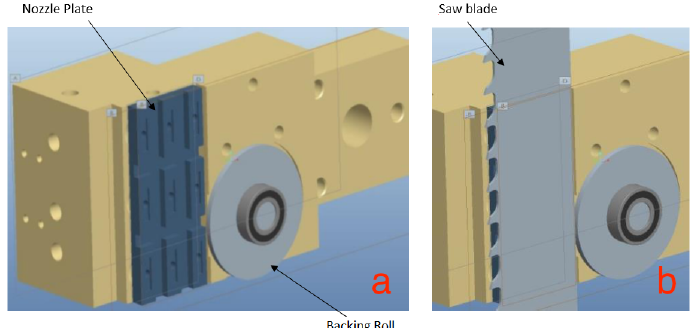
Figure 5. CAD design of the hydrostatic blade guide system showing the nozzle plate, backing roll, and the holding block. ( a ) Without the bandsaw blade; ( b ) with the bandsaw blade. From the continuity equation of fluid dynamics, the mass flow rate ( ˙ m ) is given as [15]: ˙ m = A × w × ρ , whereby , A × w = ˙ V and ˙ V D = The values of the parameters used in Equation (2) are given in Table